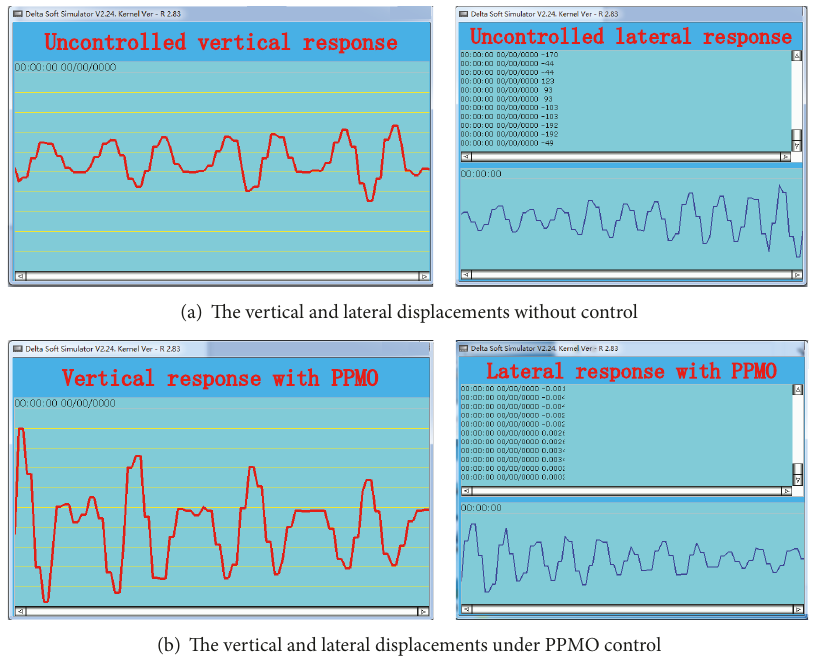
Figure 10: The vertical and lateral displacements without control (a) and those under PPMO control (b).